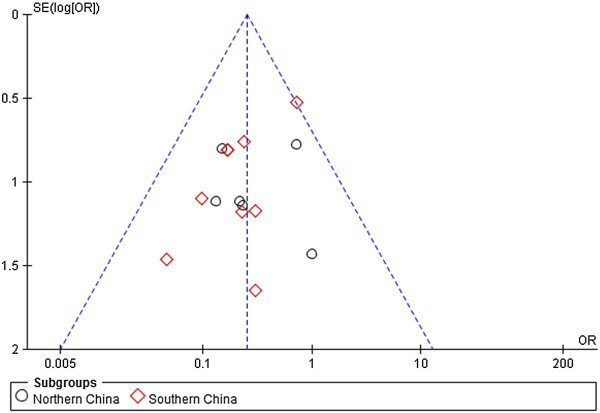
The funnel plot of infection rate.